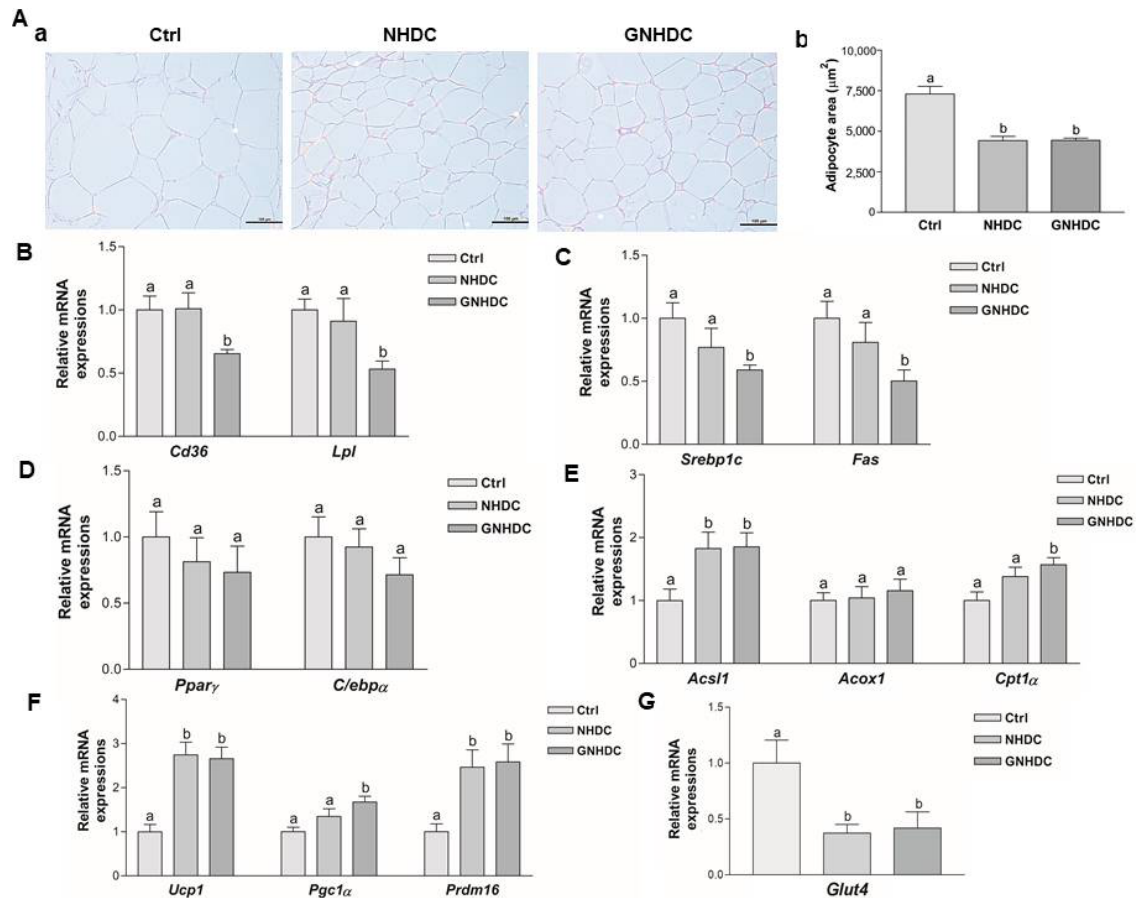
Figure 3. Effects of NHDC and GNHDC on the subcutaneous adipocyte area and the gene expressions for lipid metabolism in subcutaneous adipose tissues. Subcutaneous adipose tissues were analyzed by ( A ) ( a ) H&E staining (magnification 200×, scale bar 10 μm) with Ctrl, NHDC, and GNHDC. ( b ) Adipocyte area of subcutaneous adipose tissues was quantified ( n = 3 per group). Expression levels of mRNA were analyzed for ( B ) fatty acid uptake-related genes, Cd36 and Lpl, ( C ) lipogenesis-related genes, Srebp1c and Fas , ( D ) adipogenesis-related genes, Pparγ and C/ebpα , ( E ) β-oxidation-related genes, Acsl1 , Acox1 , and Cpt1α , ( F ) fat browning-related genes, Ucp1 , Pgc1α , and Prdm16 , and ( G ) the insulin-responsive glucose transporter gene, Glut4 . All data ( B – G ) are shown as the mean SEM quantified ( n = 9 per group) and were analyzed by one-way ANOVA with a Newman–Keuls post hoc test. Acox1 , acyl-CoA oxidase 1; Acsl1 , acyl-CoA synthetase long-chain